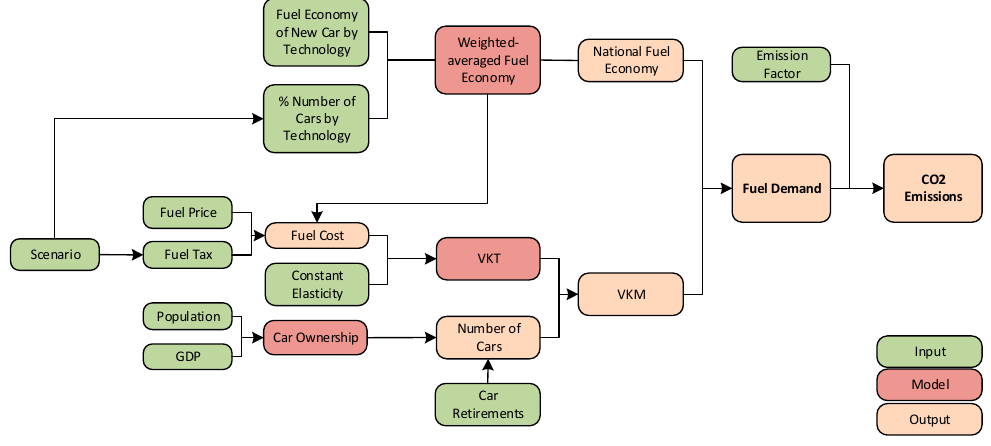
Figure 1. Schematic diagram of the methodology used.